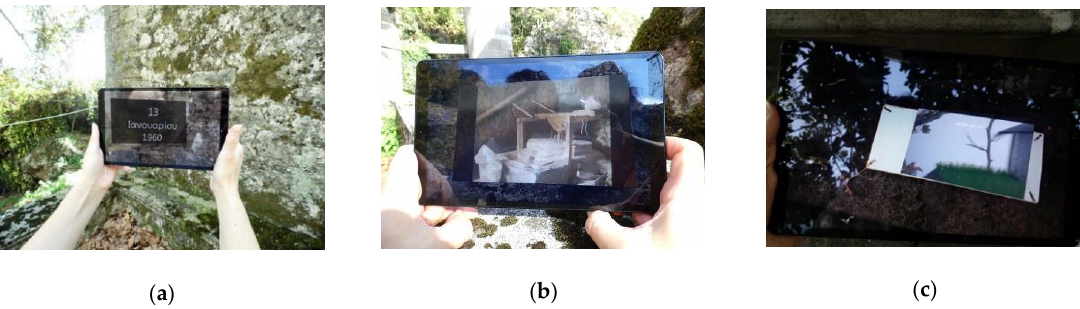
Figure 3. ( a ) Constructing the foam board label and the wooden cubes with letters; ( b ) The key, the box, the math’s quiz,